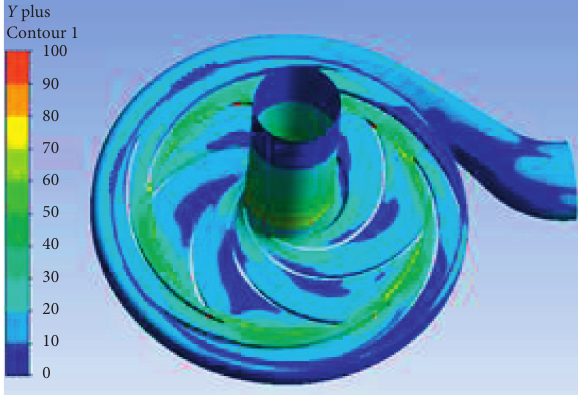
Figure 3: Distribution of Y + of the centrifugal